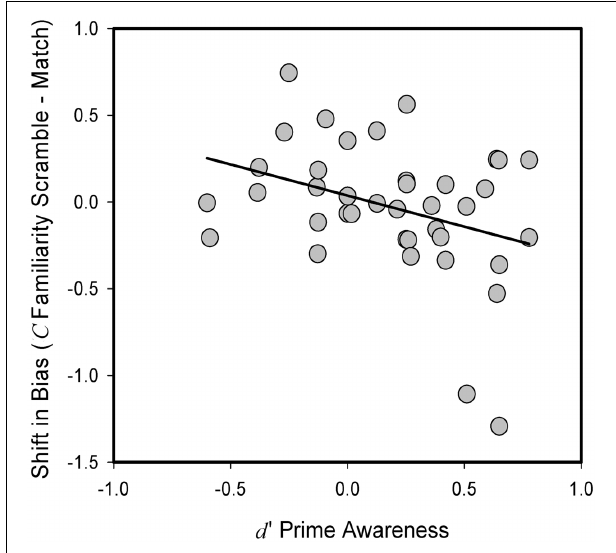
FIGURE 2 | Relationship between prime awareness ( d (cid:2) ), as measured in prime-discrimination task, and difference in criterion location ( C ) between Match and Scramble trials for “Know” responses in recognition decisions in Experiment 1. Positive priming values reflect a more liberal criterion placement for Match relative to Scramble prime condition. Dots represent data of individual